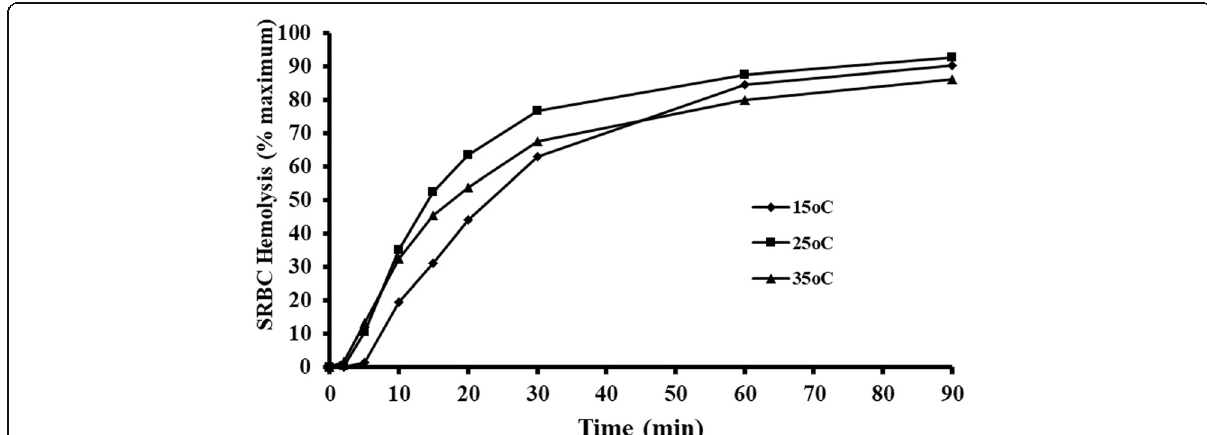
Fig. 2 Kinetic analysis of hemolysis of sheep red blood cells (SRBCs) by Crotalus viridis plasma at different temperatures. SRBCs (1%, v / v ) were incubated with an equal volume of 25% plasma of C. viridis for different amounts of time and at different temperatures. The samples were centrifuged, and the optical densities of the supernatants were measured at 540 nm and expressed as the % maximum as compared to a hemolysis positive control. The results represent the means ± standard deviations for four independent determinations